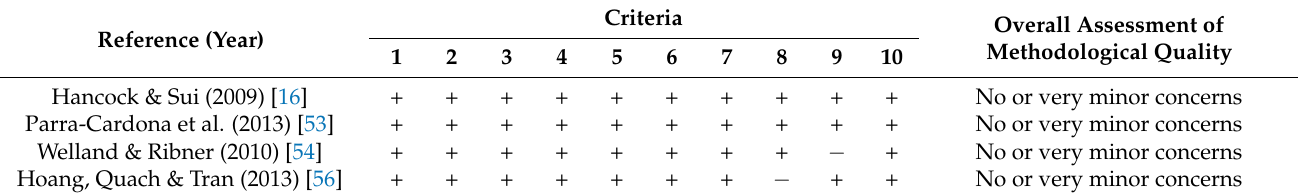
Table 1. Quality assessment of included qualitative studies.